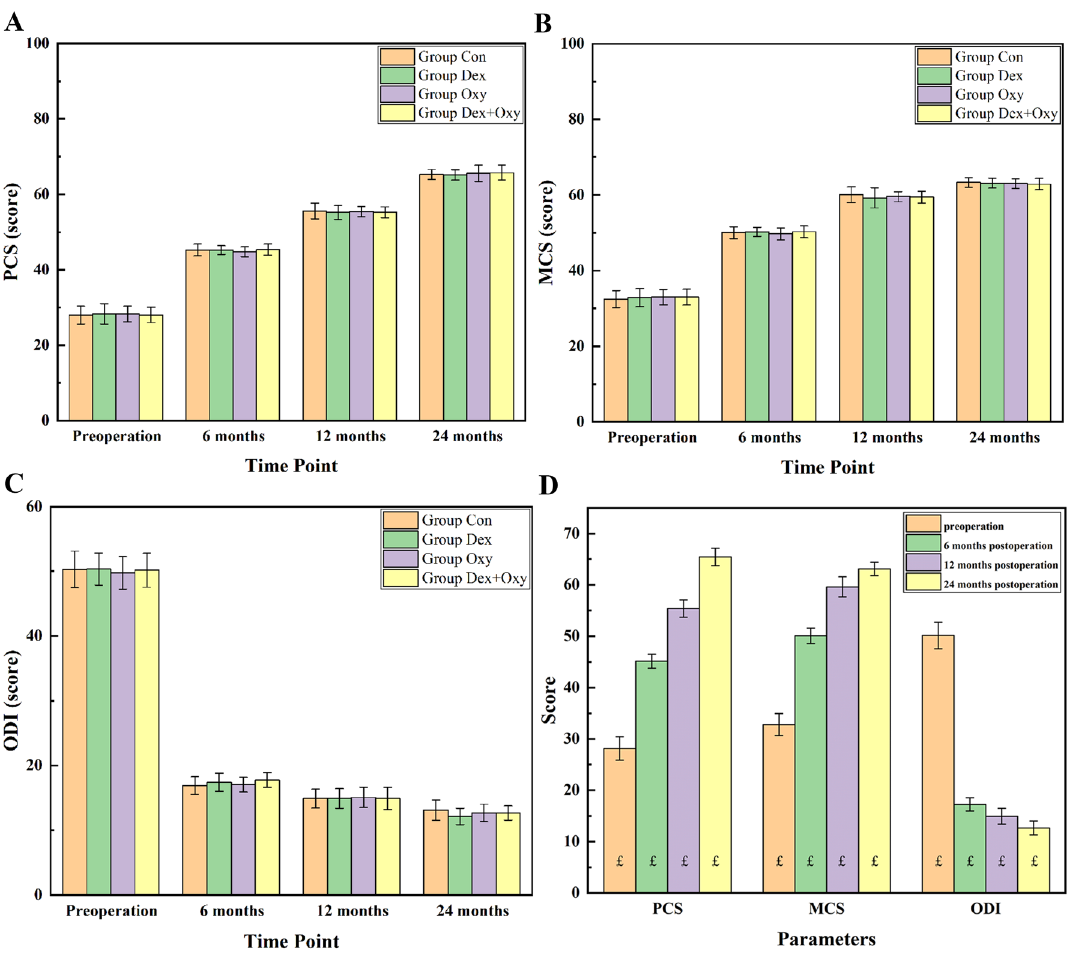
Figure 4. The clinical outcomes of PCS ( A ), MCS ( B ), and ODI ( C ) were shown in different groups. "£" represents differences were all statistical when compared with the other time points.